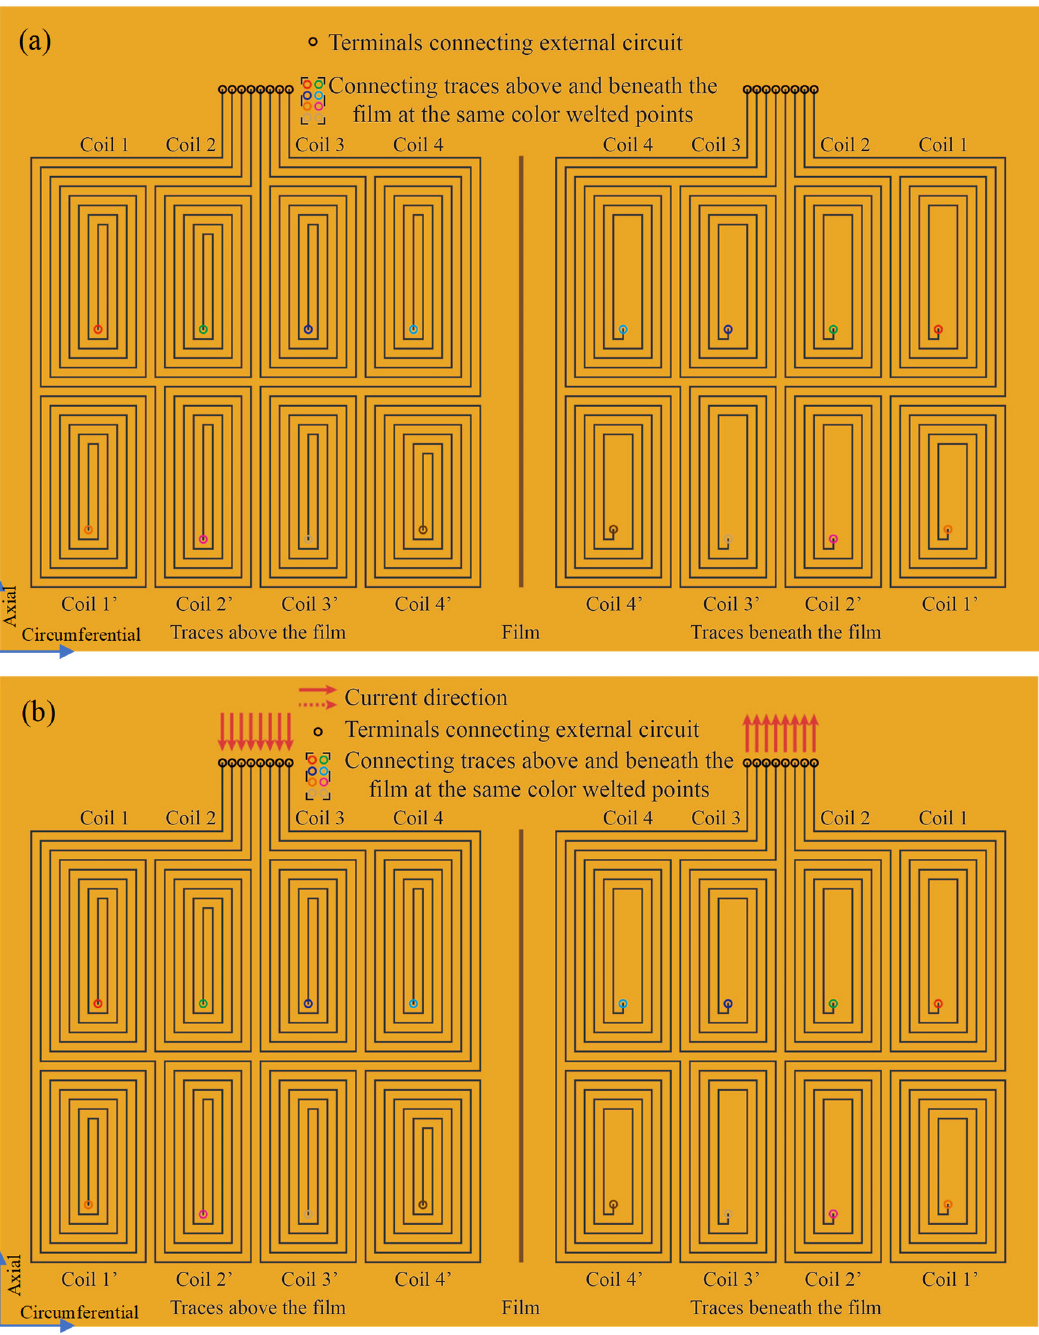
Figure 8. Sketch of the two-dimensional coil array sensing film. ( a ) Sketch of the sensing coil array; ( b )Sketch of the exciting coil.